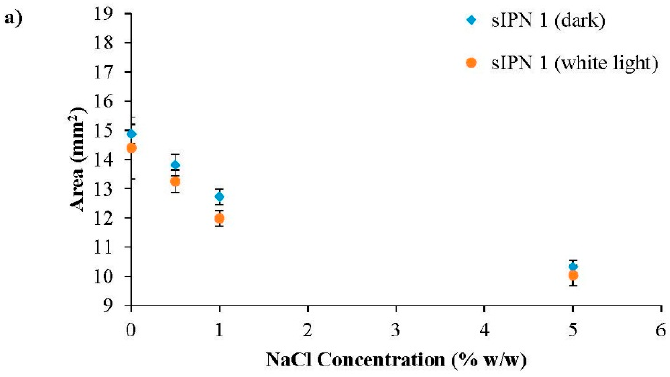
Figure 8. Figure 8. Cont .